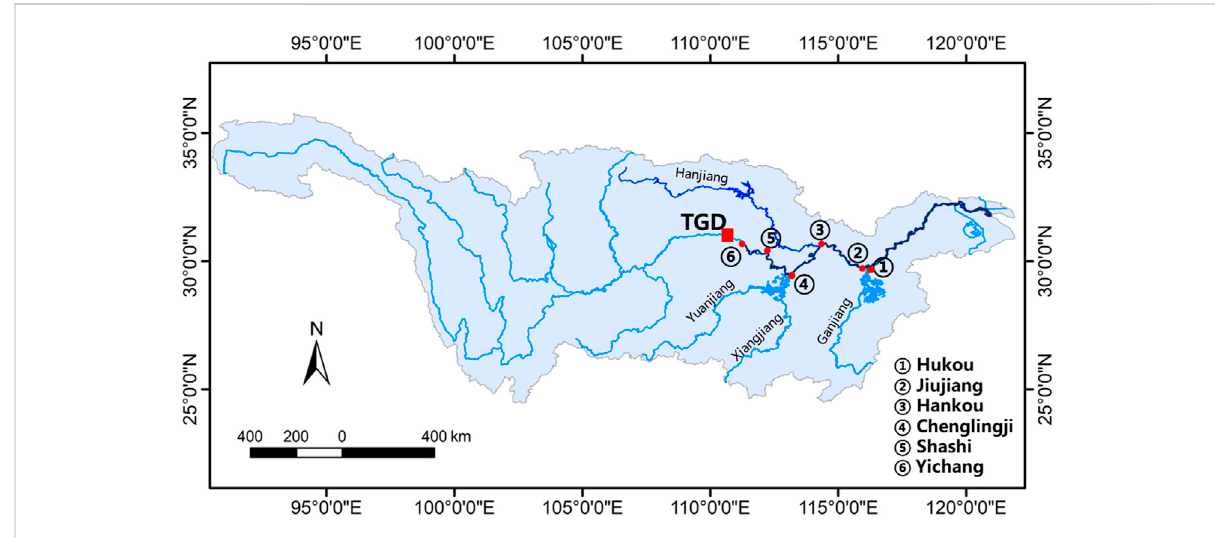
FIGURE 1 Map of the Changjiang showing location of the Three Gorges Dam and the gaging